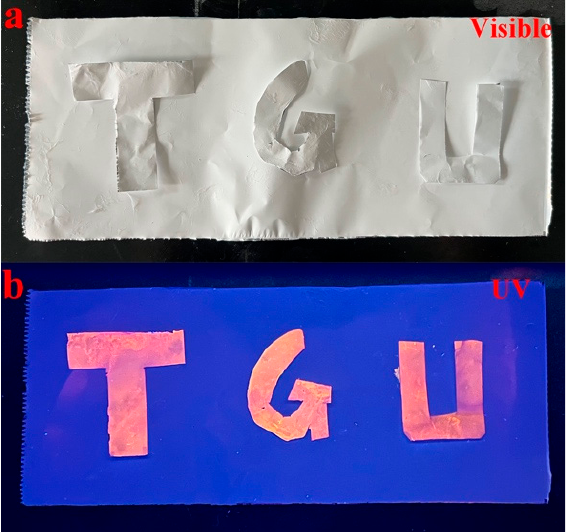
Figure 6. ( a , b ) Removed AuNCs@PAM NF “TGU” letters and underlying PAM NFs under visible light and a UV lamp.